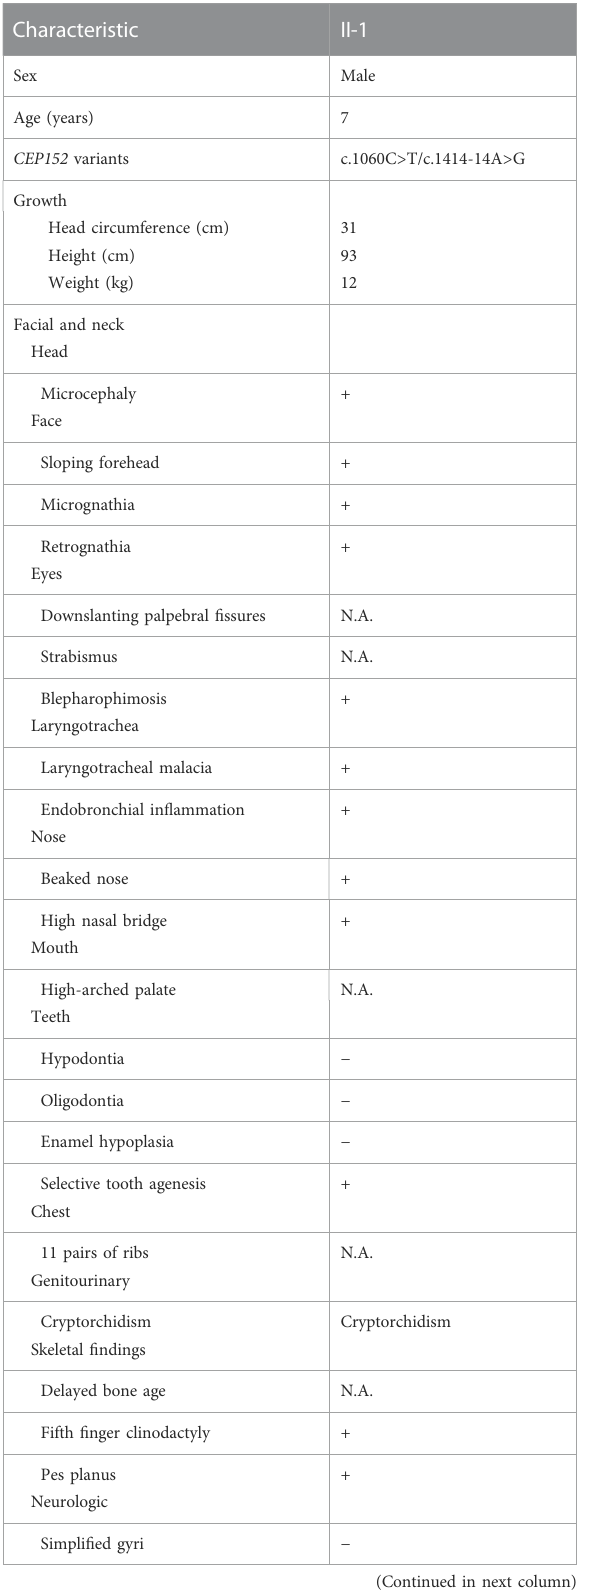
TABLE 1 Clinical fi ndings in the SCKL5 proband described in this